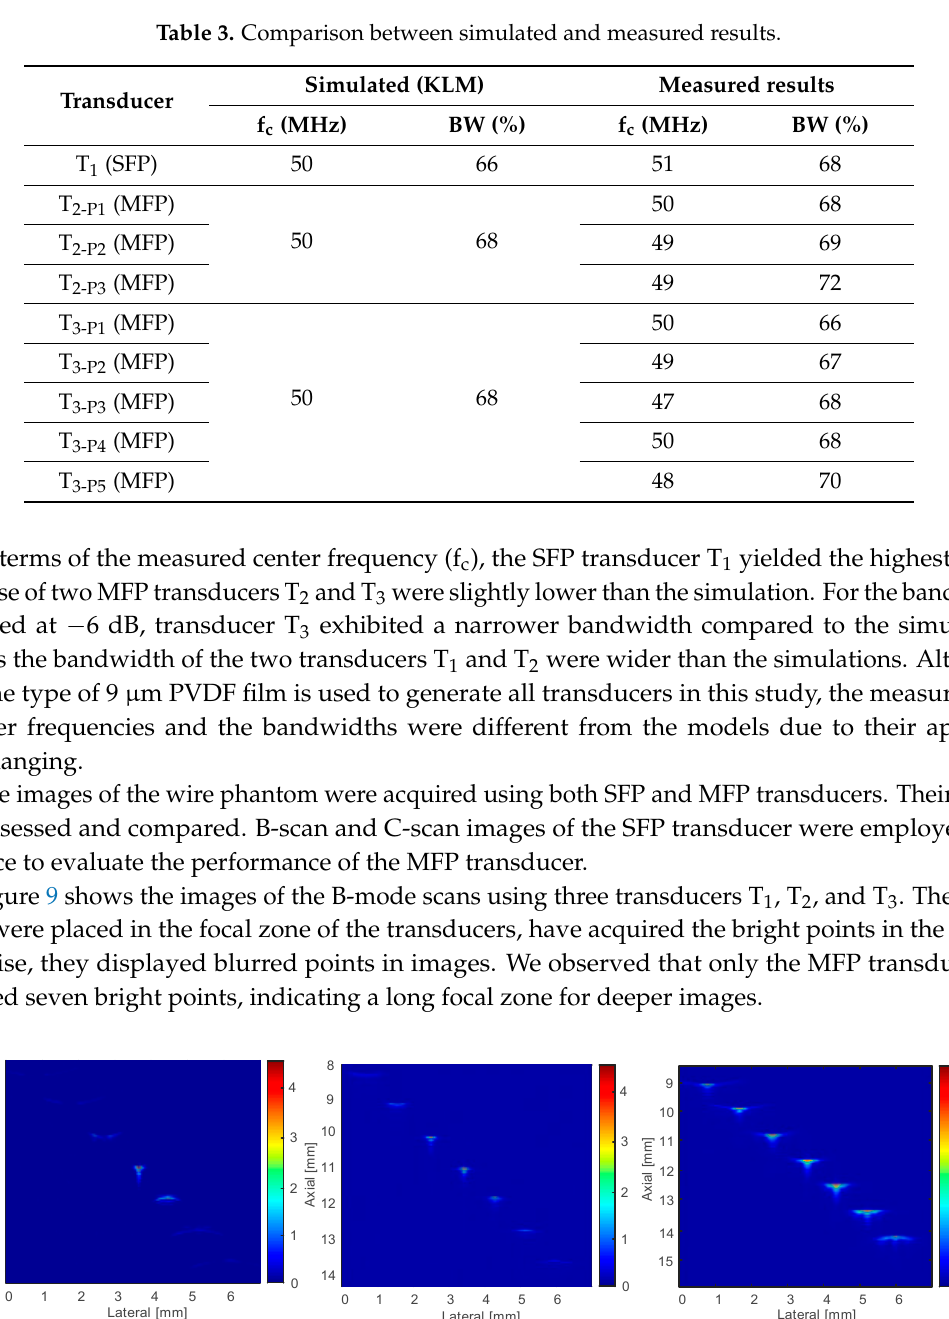
Figure 9. B-scan images of wire phantom for ( a ) single-focal point transducer T 1 , ( b ) three-focal points MFP transducer T 2 , and ( c ) five-focal points MFP transducer T 3 .